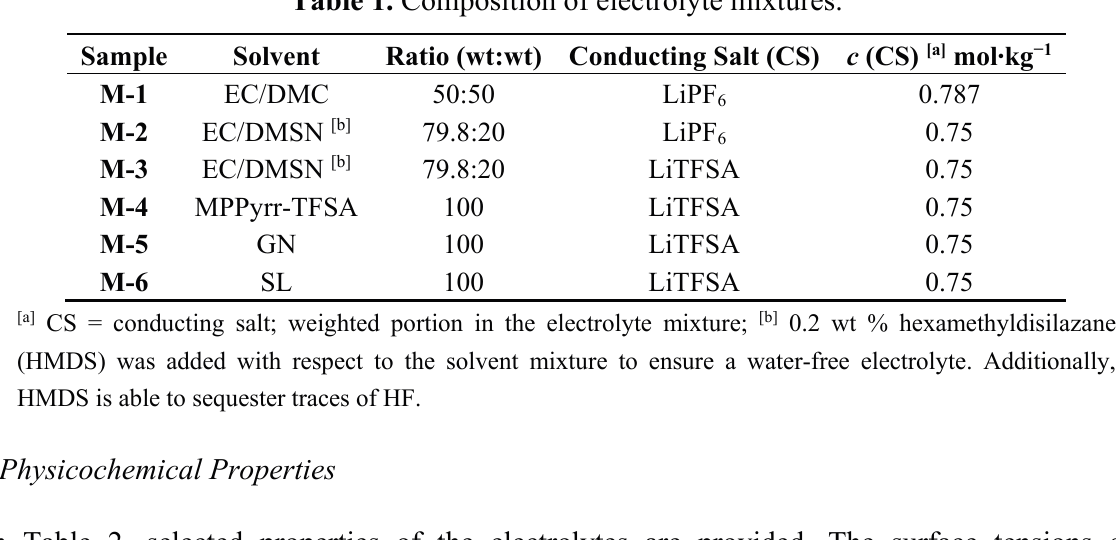
Table 1. Composition of electrolyte